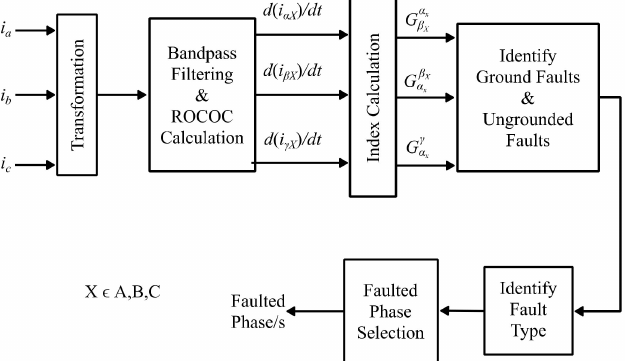
Figure 7. Schematic of the transient-based fault classification